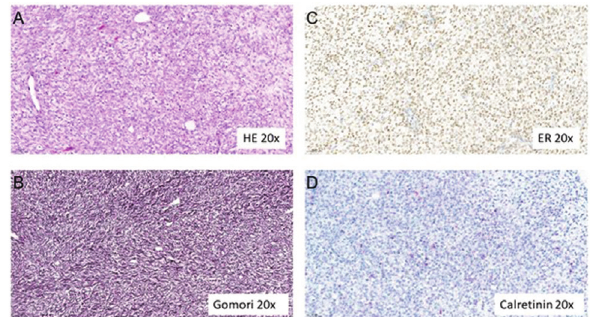
Fig. 3 Staining and immunohistochemistry in thecoma tissue: he- matoxylin and eosin (HE) staining ( A ), Gomori ’ s methenamine silver (Gomori) staining ( B ), estrogen receptor (ER) immunohistochemistry ( C ), and calretinin immunohistochemistry ( D ) under magni fi cation ( (cid:1)